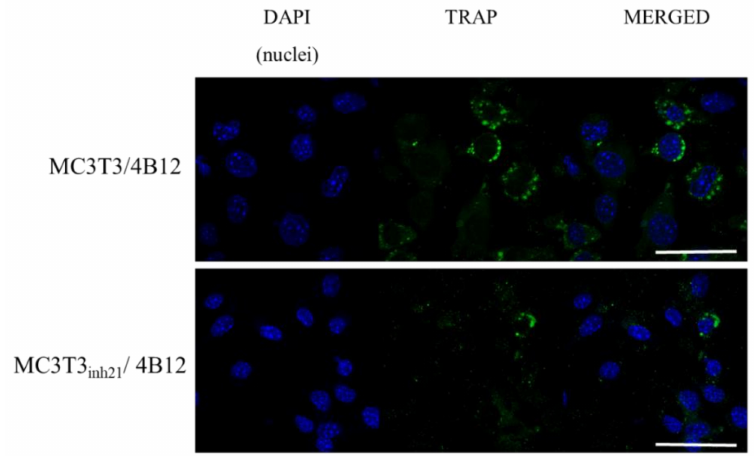
Figure 8. Representative images showing co-localization of tartrate-resistant acid phosphatase (TRAP) (green signal) with nuclei (blue, DAPI stained). The images were taken under 60-fold magnification. The scale bar is equal to 50 µ